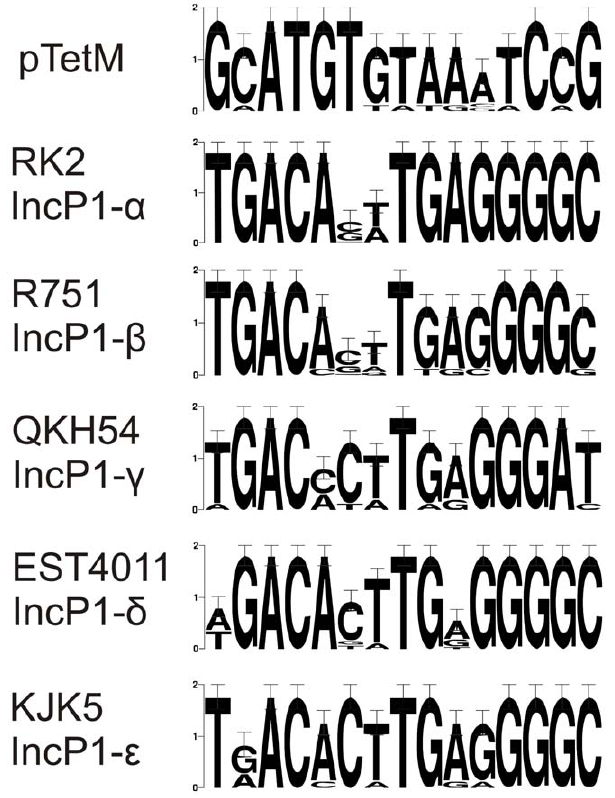
Figure 5. Comparison of the oriV iterons of different members of the IncP1 subfamilies. Weblogos were created to compare the 13 bp iterons of different members of the IncP1 subfamilies. The height of each base represents its conservation.